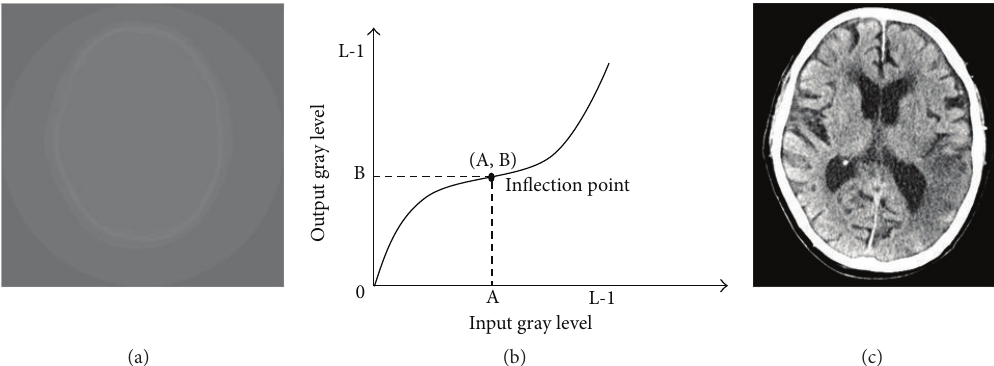
Figure 2: (a) The original brain image, (b) the cubic curve of the contrast enhancement method, and (c) the resulting image obtained after performing contrast enhancement.